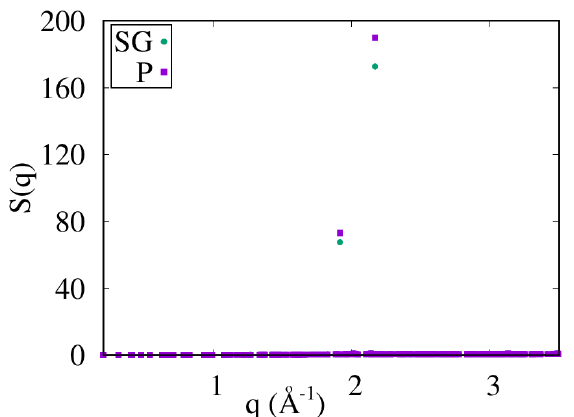
Figure 3. Static structure factor of hcp p -H 2 at density n = 0.0261 Å − 3 and temperature T = 4 K, computed in this work using the SG (circles) and P (boxes) intermolecular pair